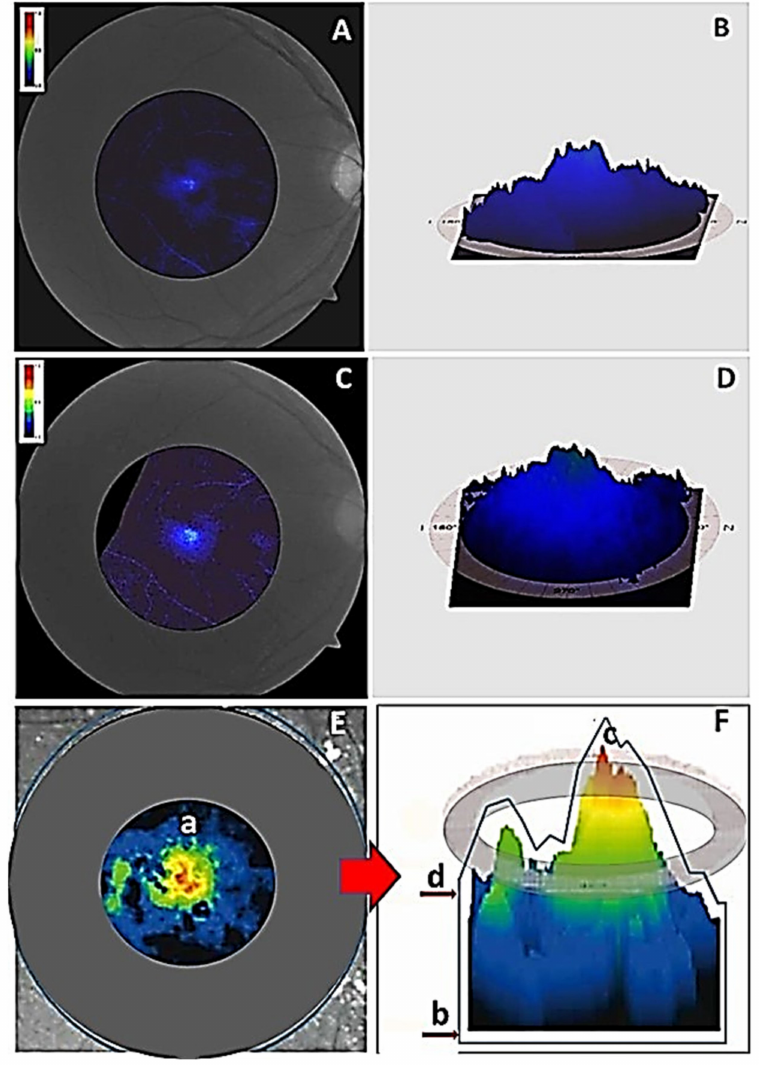
Figure 1. Comparative evaluation of the MPOD measured with the Visucam 500 ® . ( A ) Retinography of the central retina of the right eye at baseline, ( B ) Distribution of the macular pigment and the peak at the foveal level of the right eye at baseline. ( C ) Retinography of the central retina of the right eye of the same participant at end-of-study. ( D ) Distribution of the macular pigment and the peak at the foveal levels of the righ eye of the same participant at end-of-study ( E ) Schematic representation of the retinal area where the pigment is placed (a). ( F ) Illustrative drawing of the Visucam 500 parameters: total pigment volume (b), maximum of the pigment density (c), mean of the pigment density (d)